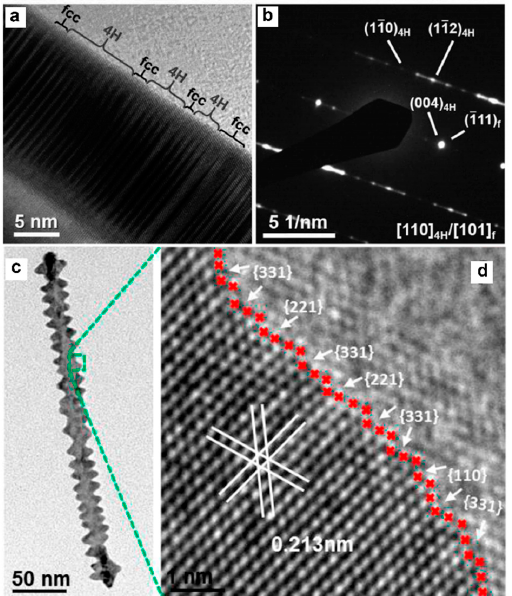
Figure 4. Structural characterization of surface defects in ( a , b ) 4H/fcc Au nanorod and ( c , d )